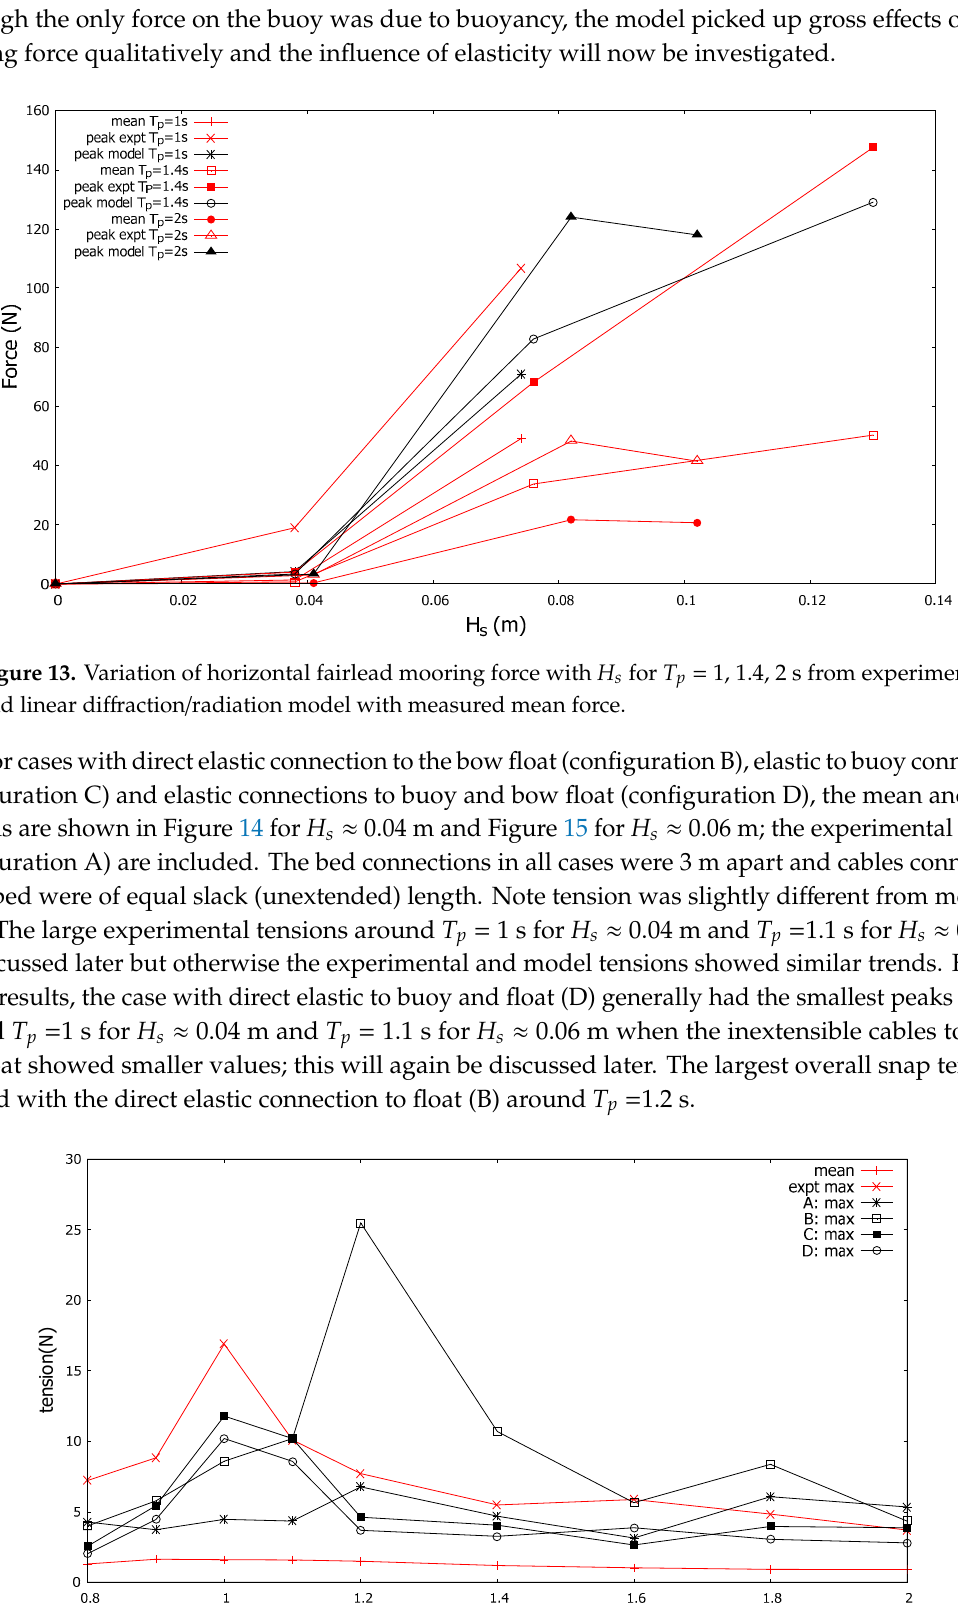
Figure 12. Variation of horizontal fairlead mooring force with 𝑇 (cid:3043) for 𝐻 (cid:3046) ≈ 0.04 m and 0.06 m from experiment and linear diffraction/radiation model with measured mean force.